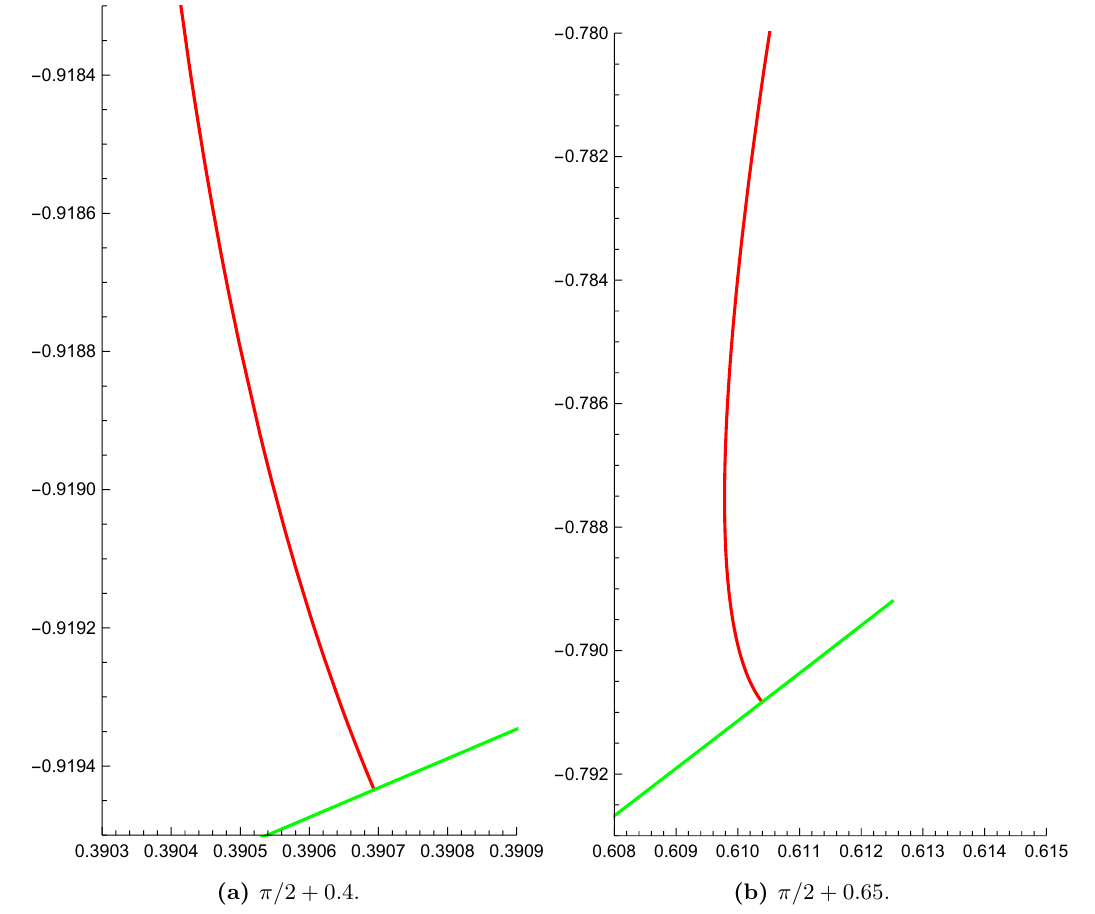
Figure 2. The zoomed in plot near the horizon for MHM surfaces when θ 2 = 0 . 2 . The captions denote the angle at which the surfaces reach the horizon